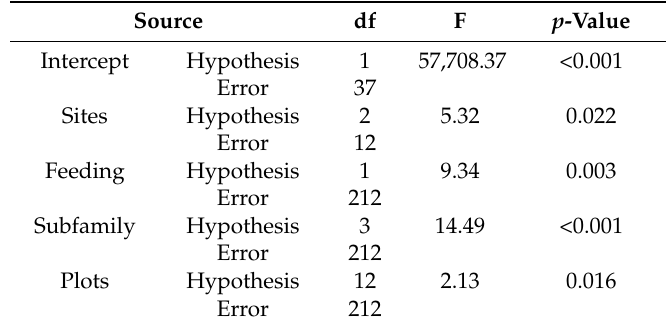
Table A6. Results of generalized linear models (GLM) that best fit the variation in isotope composition of δ 13 C in termites within tropical dry (cid:104)